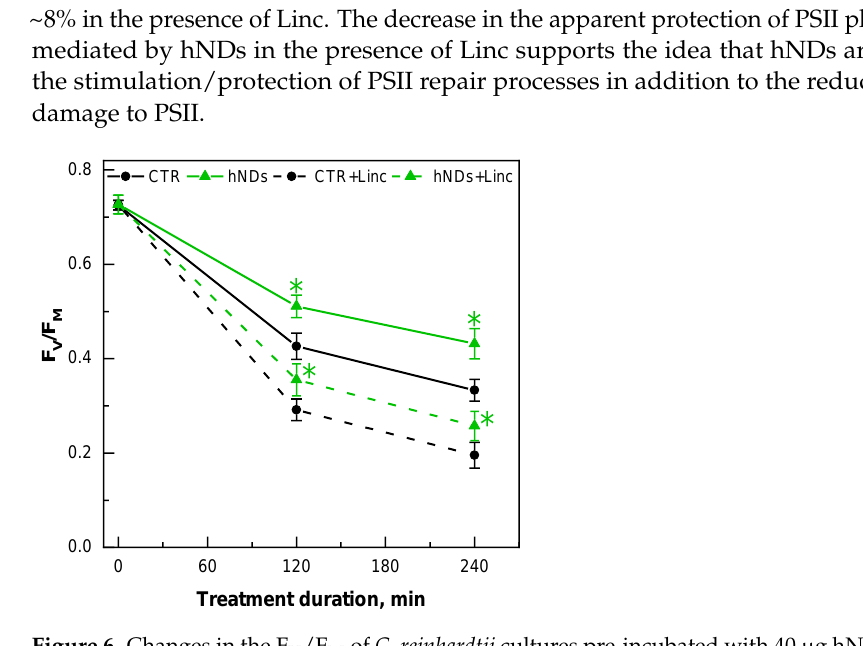
Figure 6. Changes in the F V /F M of C. reinhardtii cultures pre-incubated with 40 µ g hNDs/mL for 24 h and control cells exposed to a PPFD of 1000 µ mol/m 2 /s for 4 h. Where indicated, 400 µ g Linc/mL was added at the start of the HL treatment. Asterisks indicate statistically significant differences between the CTR and hND samples at corresponding time points at p < 0.05. Means of 2 independent experiments with 3 biological replicates (±SD, n = 6).